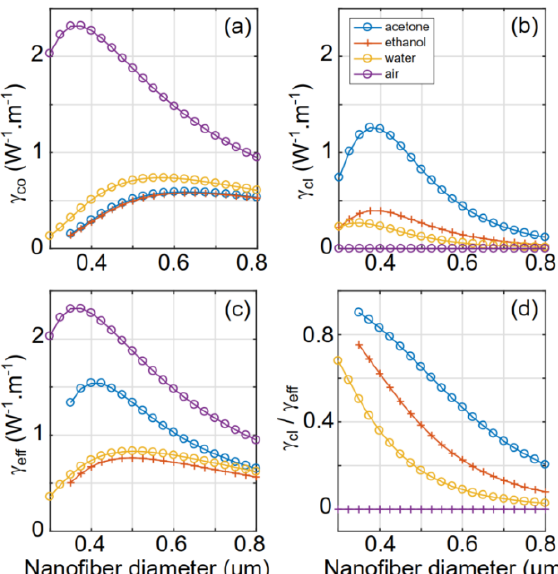
Figure 1. Evolution in function of the nanofiber diameter and for different surrounding media of (a) the nonlinear parameter contribution of the silica core γ co (b) the nonlinear parameter contribution of the cladding γ cl , (c) the whole effective nonlinear parameter γ eff , and (d) the γ cl / γ eff ratio. Wavelength λ =